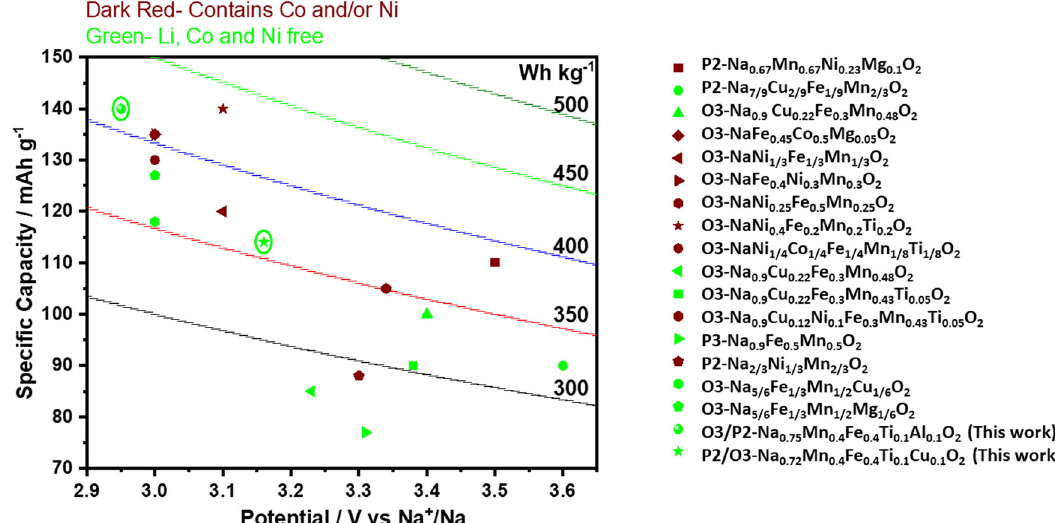
Fig. 4 Comparison of the fi rst cycle discharge energy of various Mn/Fe-based sodium layered oxides. Selected materials contained suf fi cient Na for reasonable initial coulombic ef fi ciencies, had a high average discharge potential of ca. 3 V or above and good cycling stability of at least 80% retention over at least 50 cycles. Dark red symbols correspond to Ni and/or Co-containing materials, while green symbols demonstrate that a material is Li, Co, and Ni- free. Our example bi-phasic materials are highlighted by green circles 16 – 28